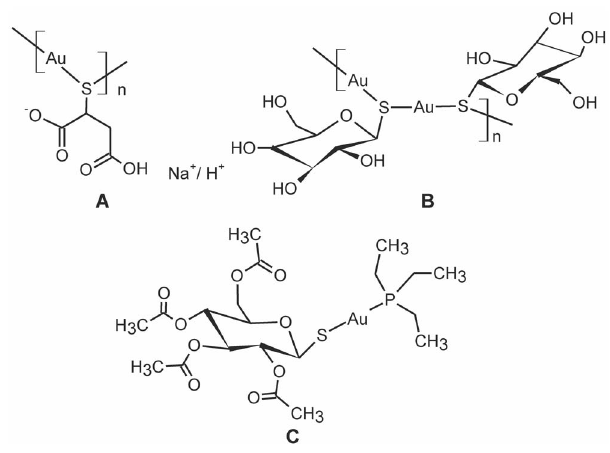
Figure 1. Schematic representations of gold(I) complexes used as anti-inflammatory drugs. A : Sodium aurothiomalate (Myochrysin, sodium {(2-carboxy-1-carboxylatoethyl)thiolato}gold(I)); B : Aurothioglu- cose (Solganol, {(2 S ,3 R ,4 S ,5 S ,6 R )-3,4,5-trihydroxy-6-(hydroxymethyl)- oxane-2-thiolato}gold(I)); C : Auranofin (Ridaura, triethylphosphine- (2,3,4,6-tetra- O -acetyl-1-D-thiopyranosato- S )gold(I)).